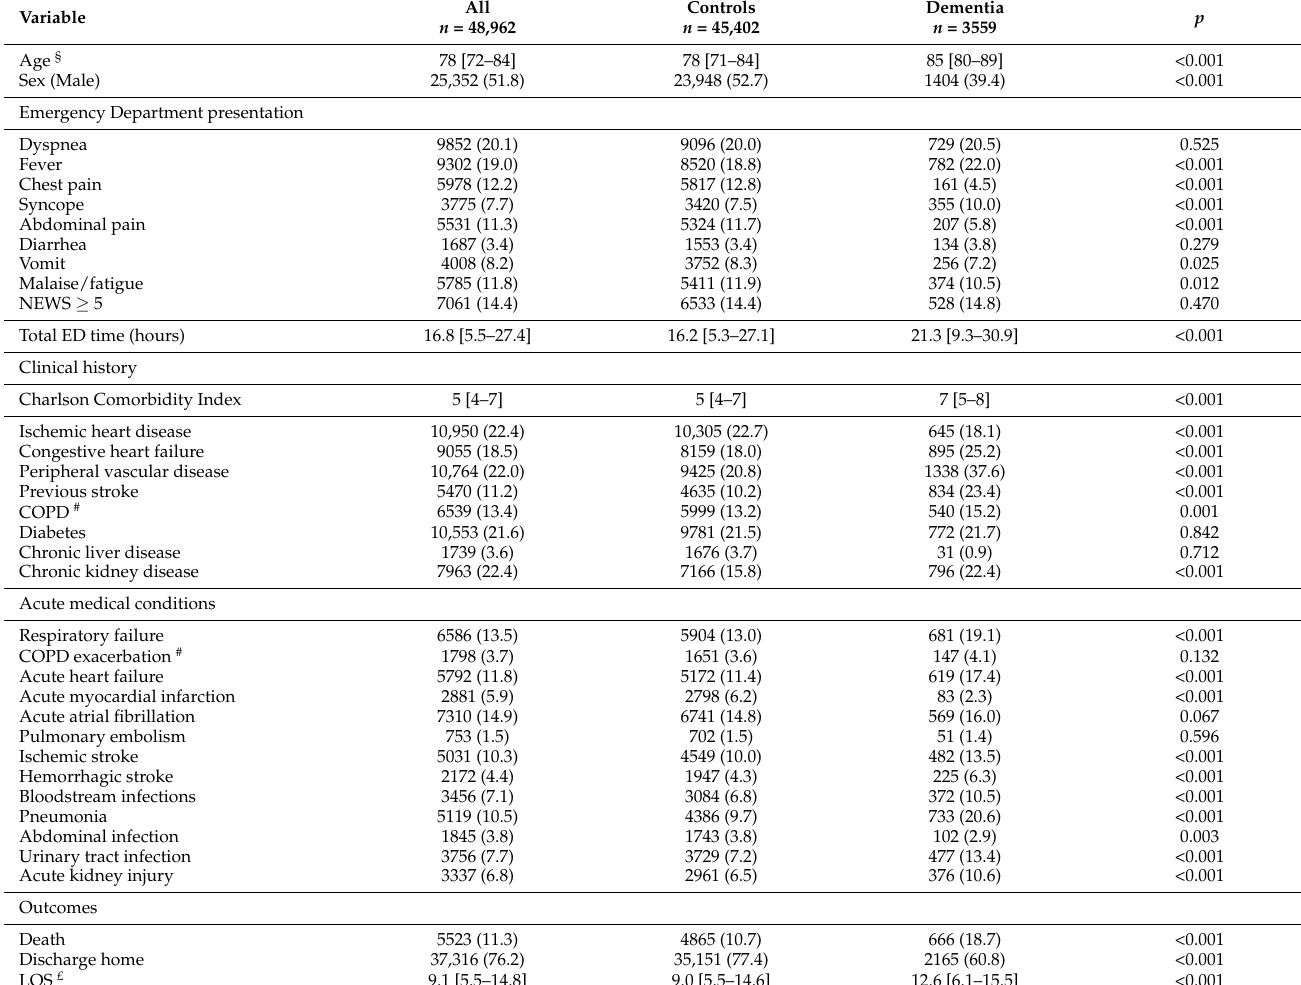
Table 1. Population demographics of all adults ≥ 65 years admitted to the Emergency Department (ED) and subsequently